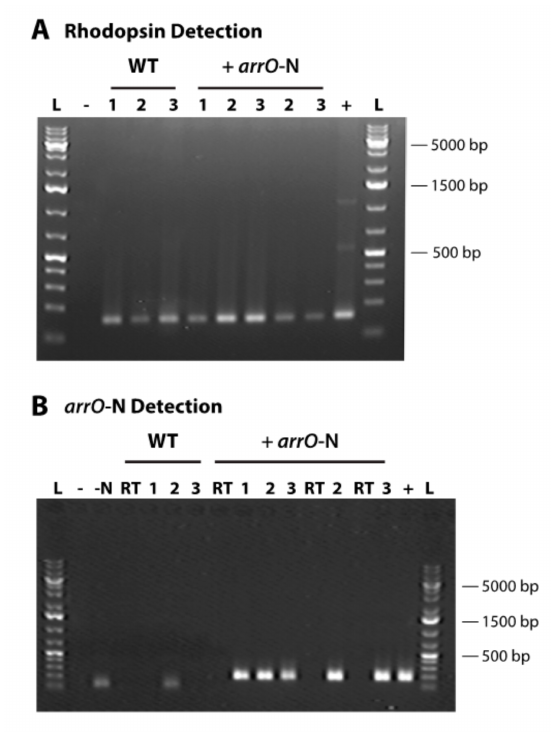
Figure 3. Detection of rhodopsin and arrO -N ( arrO plus rhodopsin intergenic region) gene in three di ff erent transformation events and in wild-type Oxyrrhis marina cells; ( A ) O. marina’s rhodopsin gene detected in cDNA libraries for both transformed ( + arrO -N) and wild-type cells (WT); ( B ) arrO -N gene expression detected in the cDNAs of transformed O. marina through nested PCR; “L”, GeneRuler TM 1kb Plus DNA Ladder (Thermo Scientific); “WT”, wild-type; “ + arrO -N”, transformed cells; “-”, no template control in first PCR; “-N”, no template control in nested PCR; “RT”, no reverse transcriptase control; “ + ”, plasmid positive control for arrO -N gene and O. marina gDNA for rhodopsin gene; “1”, N6 library; “2”, OdT; “3”, MdT